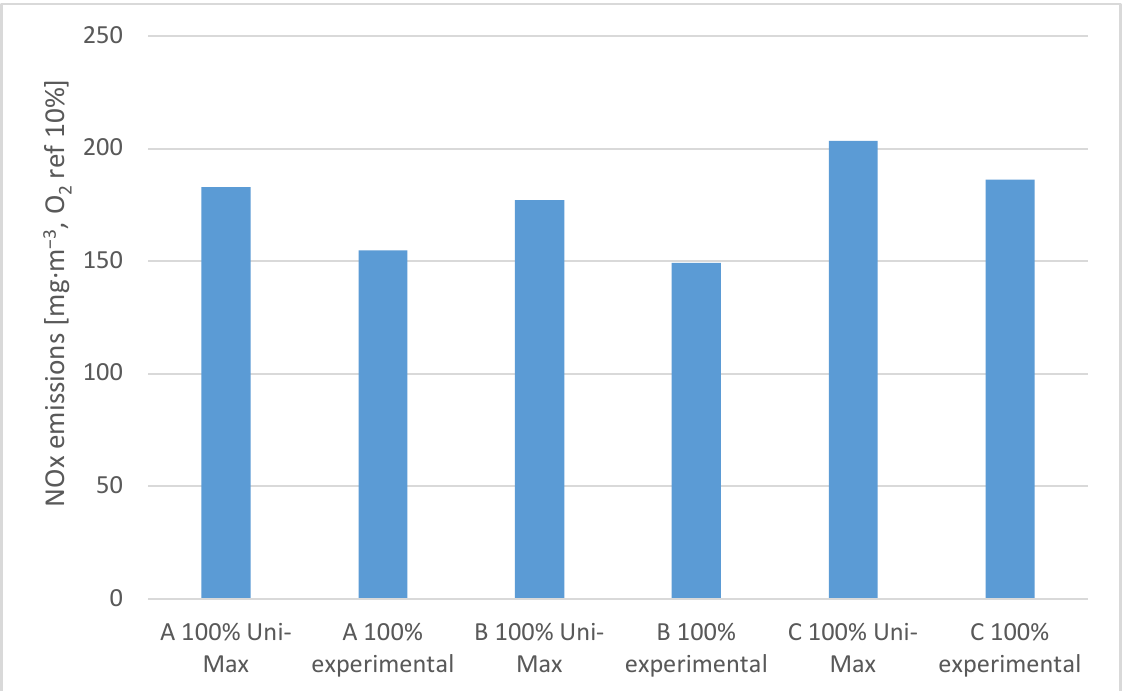
Figure 8. Comparison of average statistical NOx emissions from the combustion of three types of wood pellets in two different burners at full load.